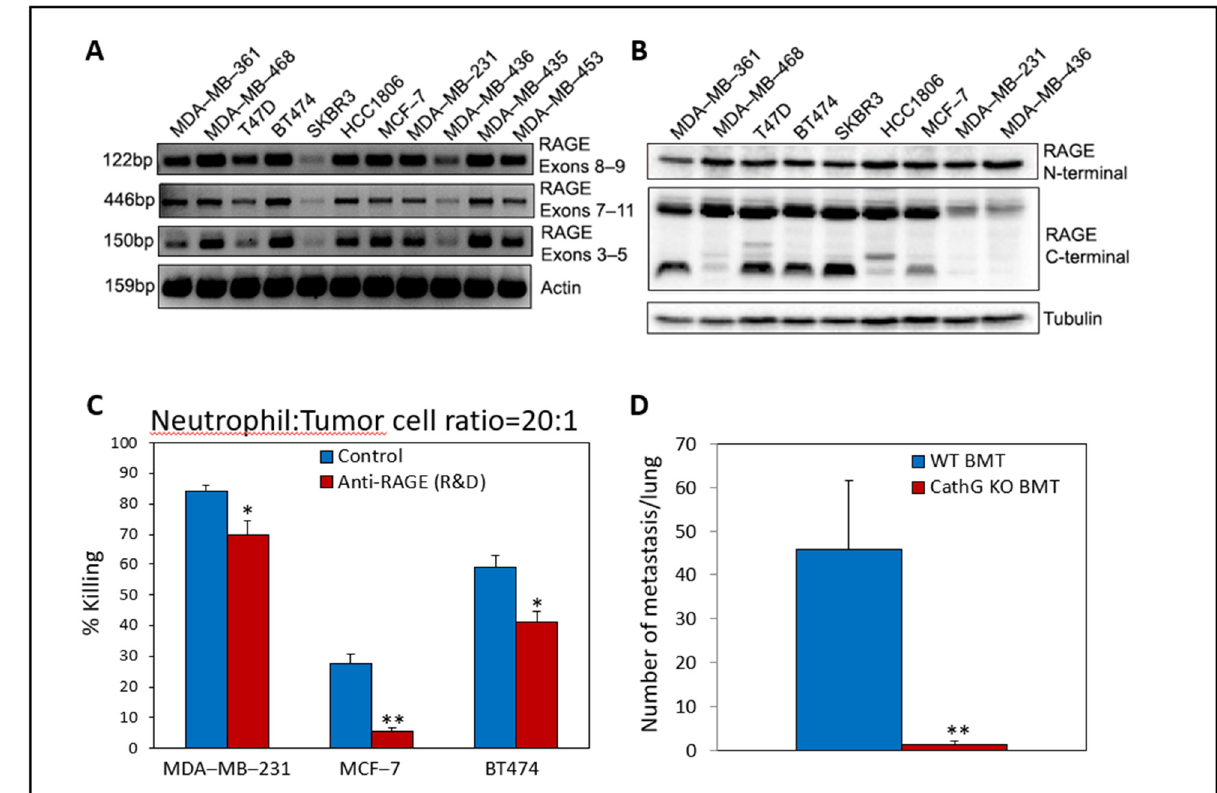
Figure 6. RAGE expression in various human cancer cells and its involvement in neutrophil-mediated cytotoxicity. ( A ). PCR analysis of mRNA levels as determined by using primer pairs for the indicated RAGE exons and primer pairs for β - actin. ( B ). Western blot analysis of protein expression levels as determined by using antibodies to the N -terminal part of RAGE (A-9, Santa Cruz, sc-365154), the C -terminal part of RAGE (Abcam, ab3611) or α -Tubulin (Sigma, clone DM1A). ( C ). Neutralizing antibodies to human RAGE (R&D) (AF1145; 0.5 μ g/mL) inhibited neutrophil-induced tumor cell killing toward MCF-7 breast cancer cells and to a lesser extent toward MDA-MB-231 and BT474 breast cancer cells. n = 3 * p < 0.05, ** p < 0.01. ( D ). AT3 breast cancer cells do not form metastasis in mice, which have been transplanted with Cathepsin G KO bone marrow cells. One hundred thousand GFP-expressing AT3 breast cancer cells were injected intravenously into mice that had been transplanted with either wild-type (WT) or CathG KO bone marrow. The number of GFP-positive metastatic foci in the lungs were counted 8 days later. n = 4 for control and n = 3 for CathG KO. ** p < 0.01. BMT—bone marrow transplanted. These experiments were performed in the laboratory of Prof. Zvi Granot according to the ethics of the Hebrew University’s Institutional Committees.